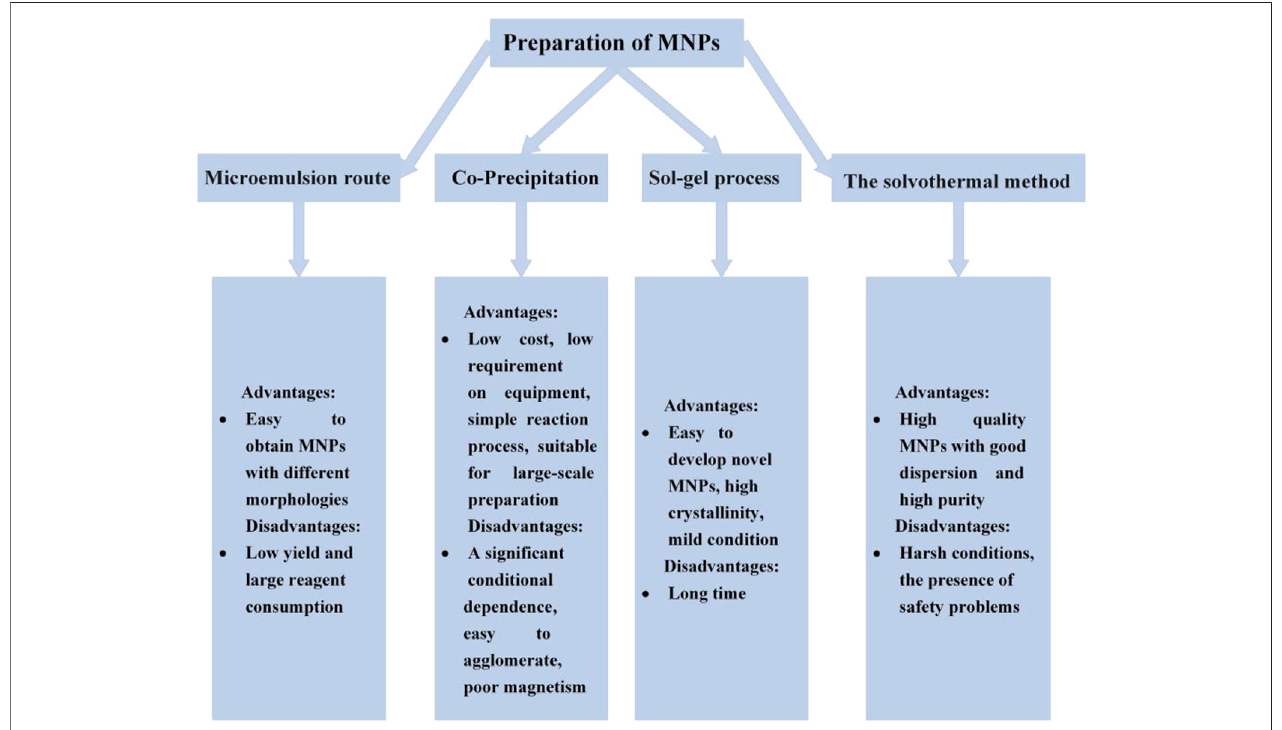
FIGURE 1 | The advantages and disadvantages of the method for